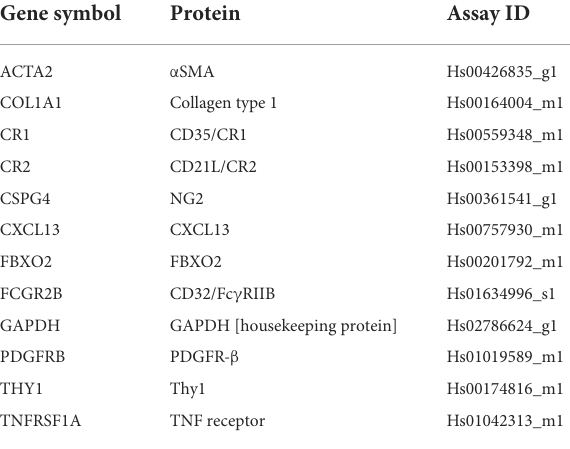
TABLE 1 TaqMan gene expression assays used in the study (Thermo-Fisher Scientific Cat Number 4331182). Gene symbol Protein Assay